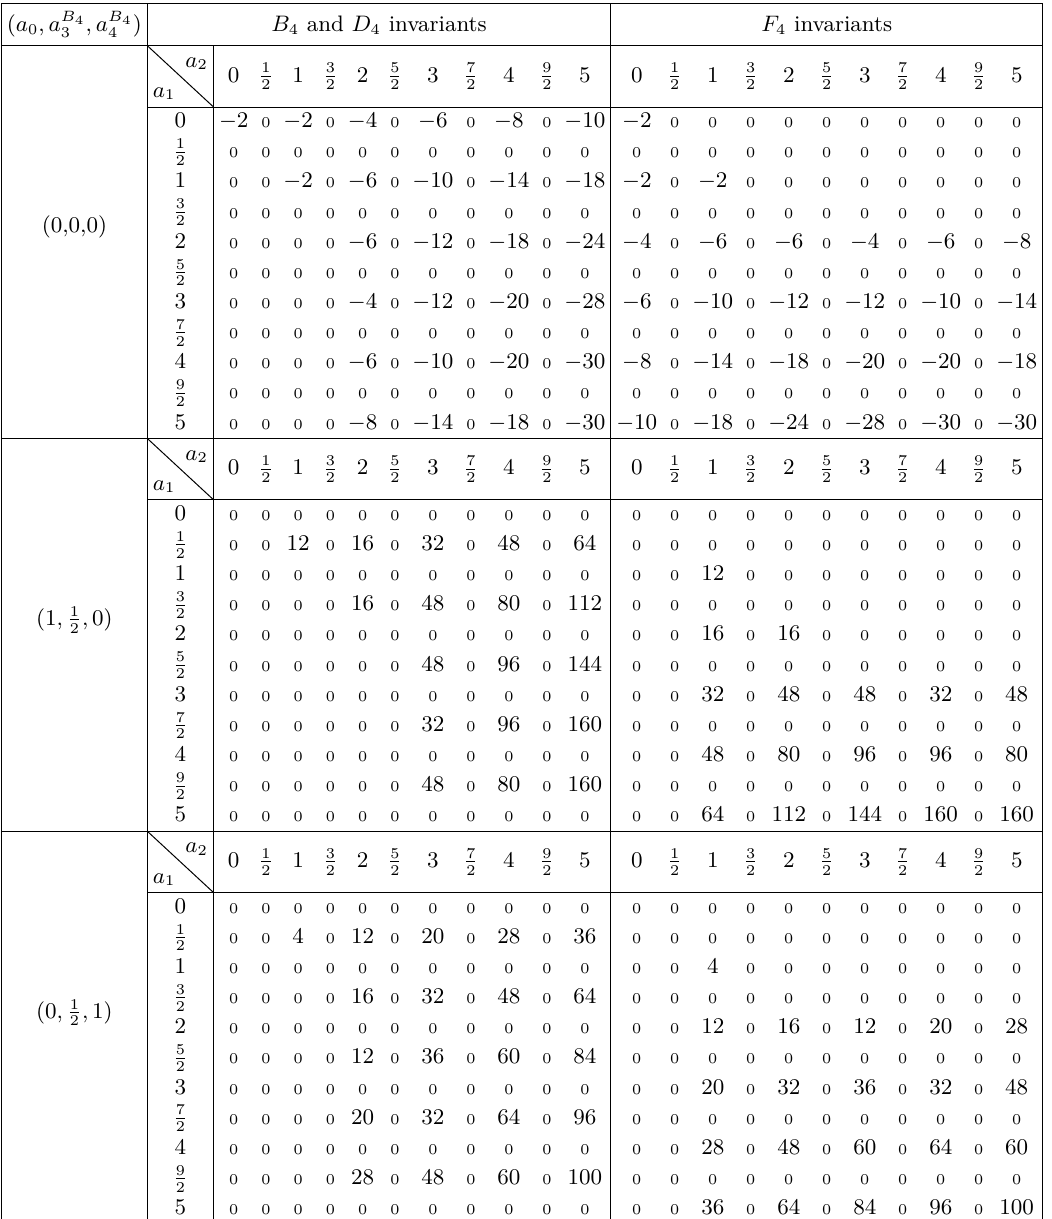
Table 3 . Some genus 0 Gromov-Witten invariants of the B 4 , D 4 and F 4 theories over F 2 . On B 4 the left, we give the values of a , which determine the values of a , a B 4 0 , a 3 4 B 4 B 4 2 a B 4 and a B 4 respectively. Inside each block, a , a B 4 − a , a 4 4 3 4 3 2 2